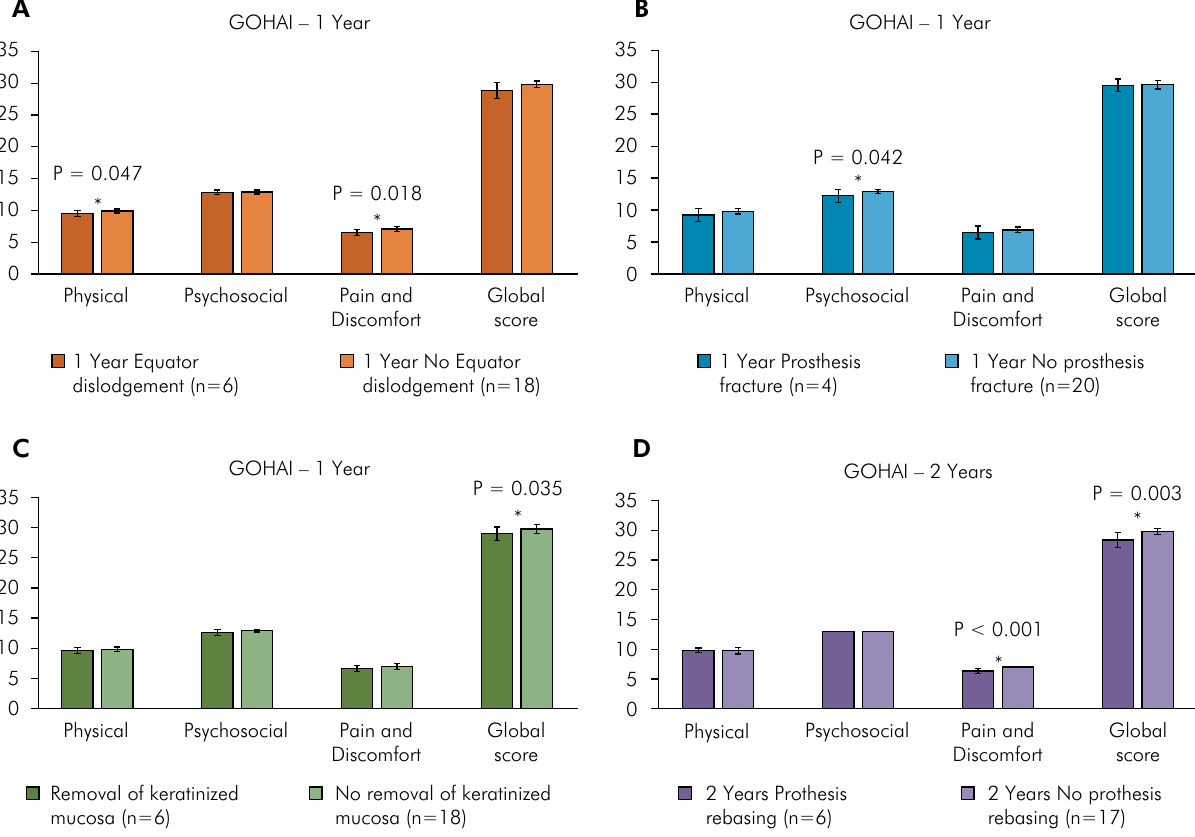
Figure 2. Influence of prosthetic events on the GOHAI questionnaire domains that had statically significant differences in the Mann-Whitney test (p < 0.05). One Year: a) Equator dislodgement influenced the Physical and Pain and Discomfort domains; b) Prosthesis fracture influenced the Psychosocial domain; c) Removal of keratinized mucosa influenced the global score. Two Years: d) Prosthesis rebasing influenced the Pain and Discomfort domain and the global